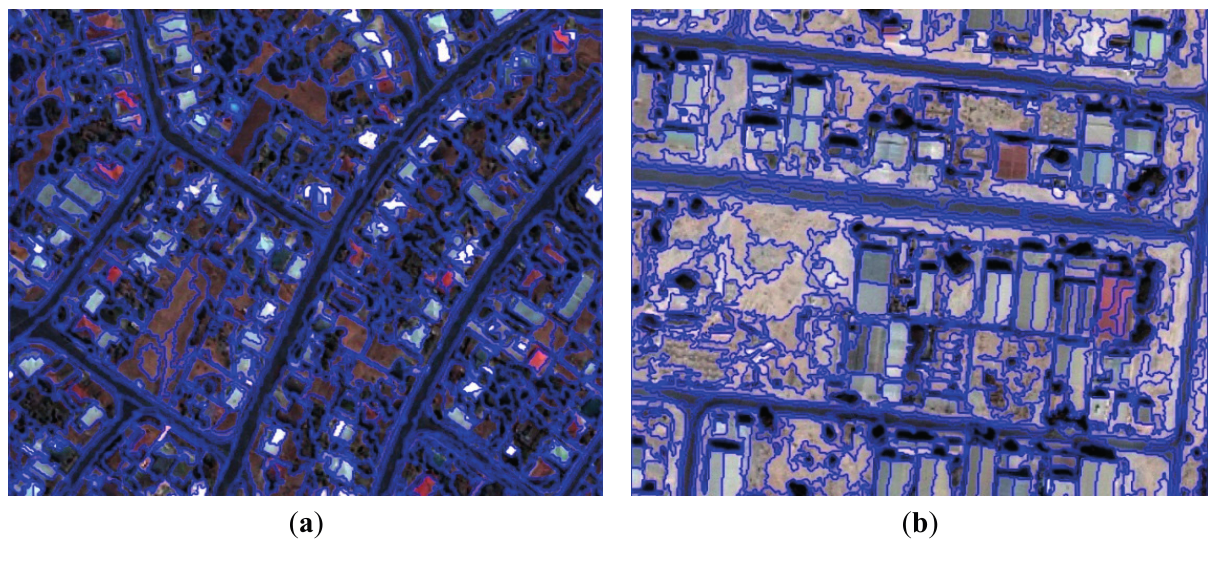
Figure 8. A segmented view of: ( a ) Hobart; ( b ) Kish.